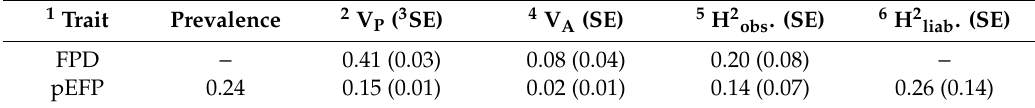
Table 2. Results of the variance component